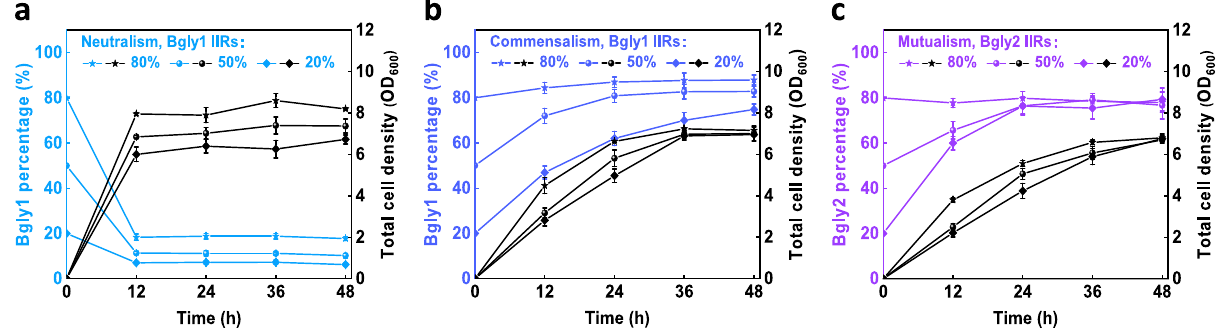
Fig. 2 Curves of cell growth and population composition in the three coculture systems. a The Neutralistic coculture; b the Commensalistic coculture; c the Mutualistic coculture. IIRs, the initial inoculation ratios. Data shown are mean ± SD ( n = 3 independent experiments). Source data are provided as a Source Data fi